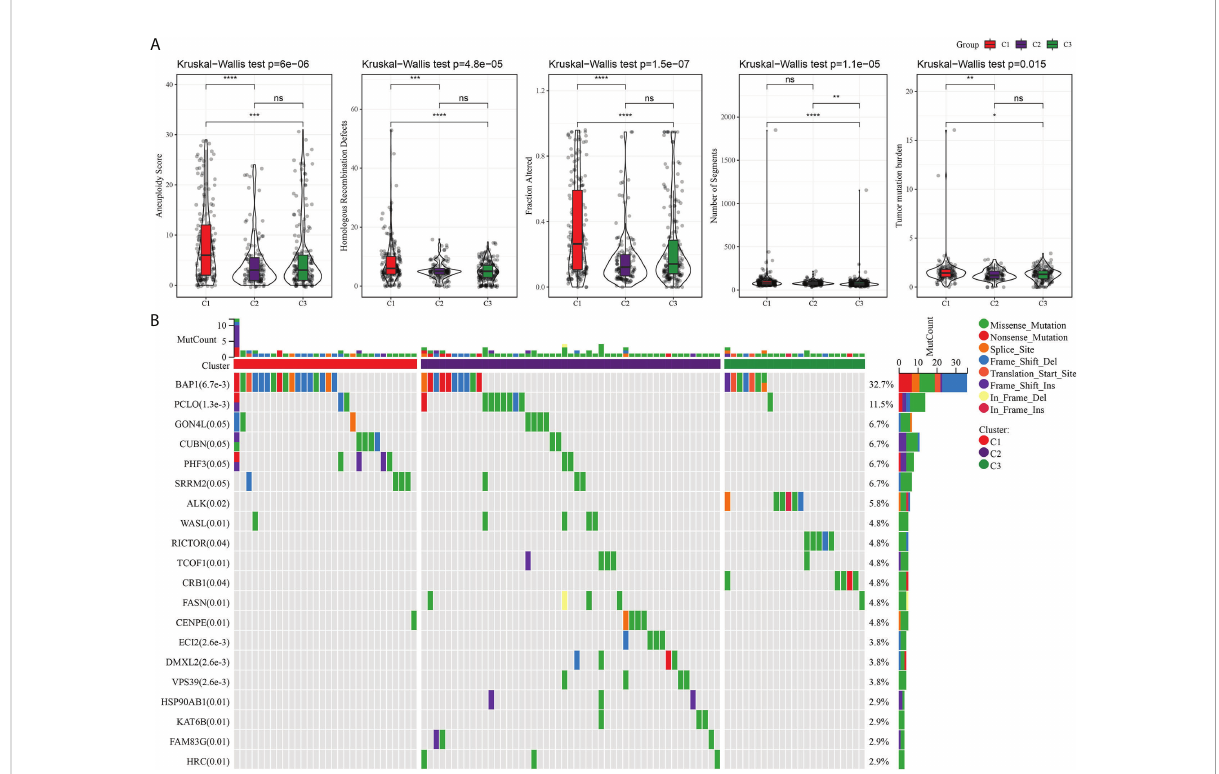
FIGURE 3 Mutation analysis of three subtypes. (A) The difference among three subtypes in aneuploidy score, HRDs, fraction altered, number of segments, and tumor mutation burden. (B) Mutation frequency and mutation pattern of the 20 most frequently mutated genes in the three subtypes. * P